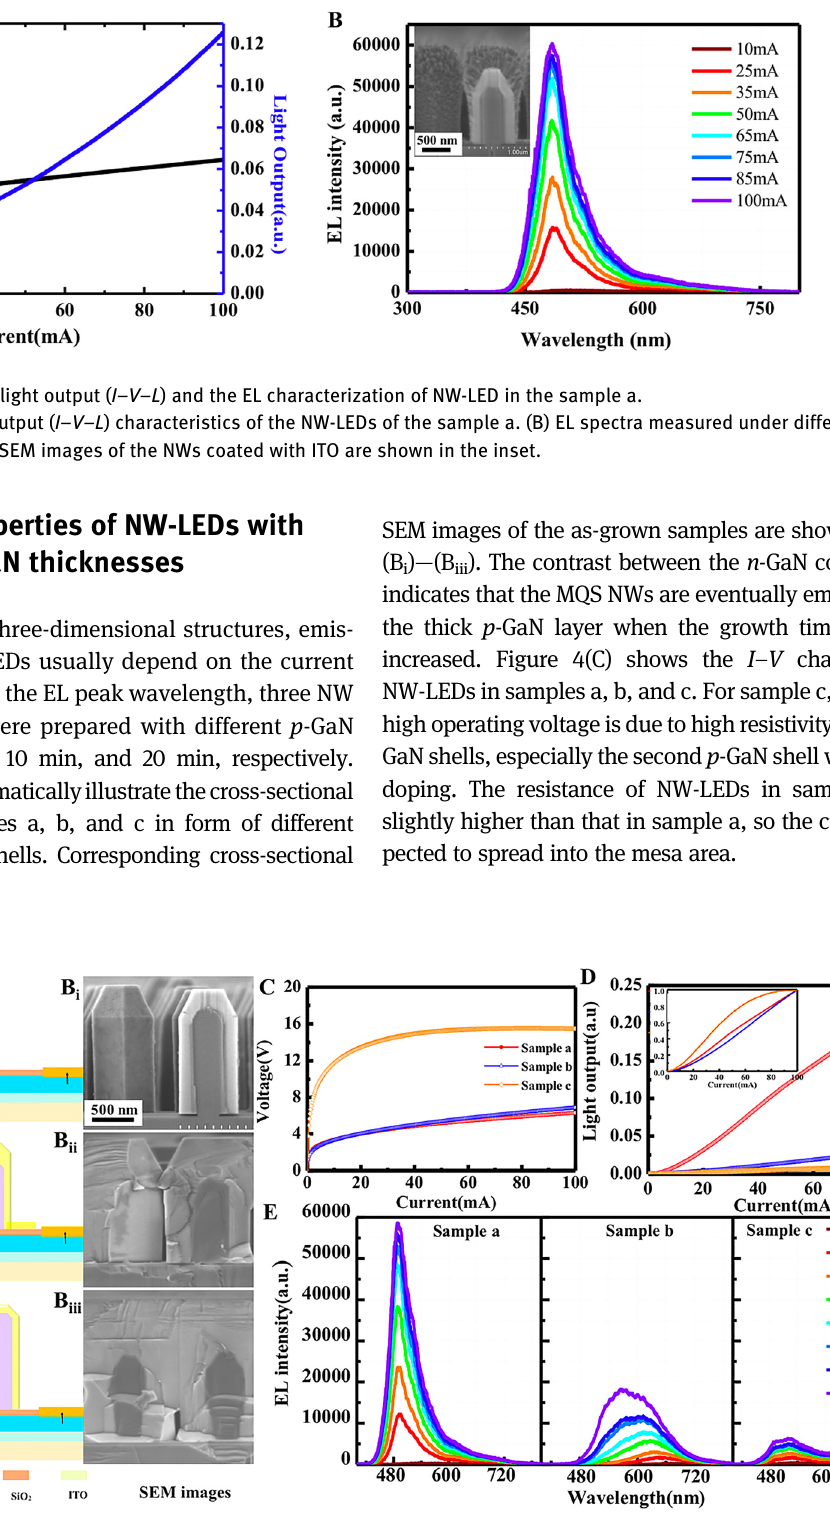
Figure 4: Morphologies and electronic-optical properties of the NWs in samples a, b, and c. (A i ) — (A iii ) schematic illustrations of the cross-sectional con fi guration of samples a, b, and c. (B i ) — (B iii ) cross-sectional SEM images of the grownsamplesa,b,andc.(C) I – V and(D) I – L characteristicsoftheNW-LEDsfabricatedfromsamplesa,b,andc.Thenormalized I – L curvesare plotted in the inset. (E) EL spectra acquired under different current injections for NW-LEDs from samples a, b, and c,